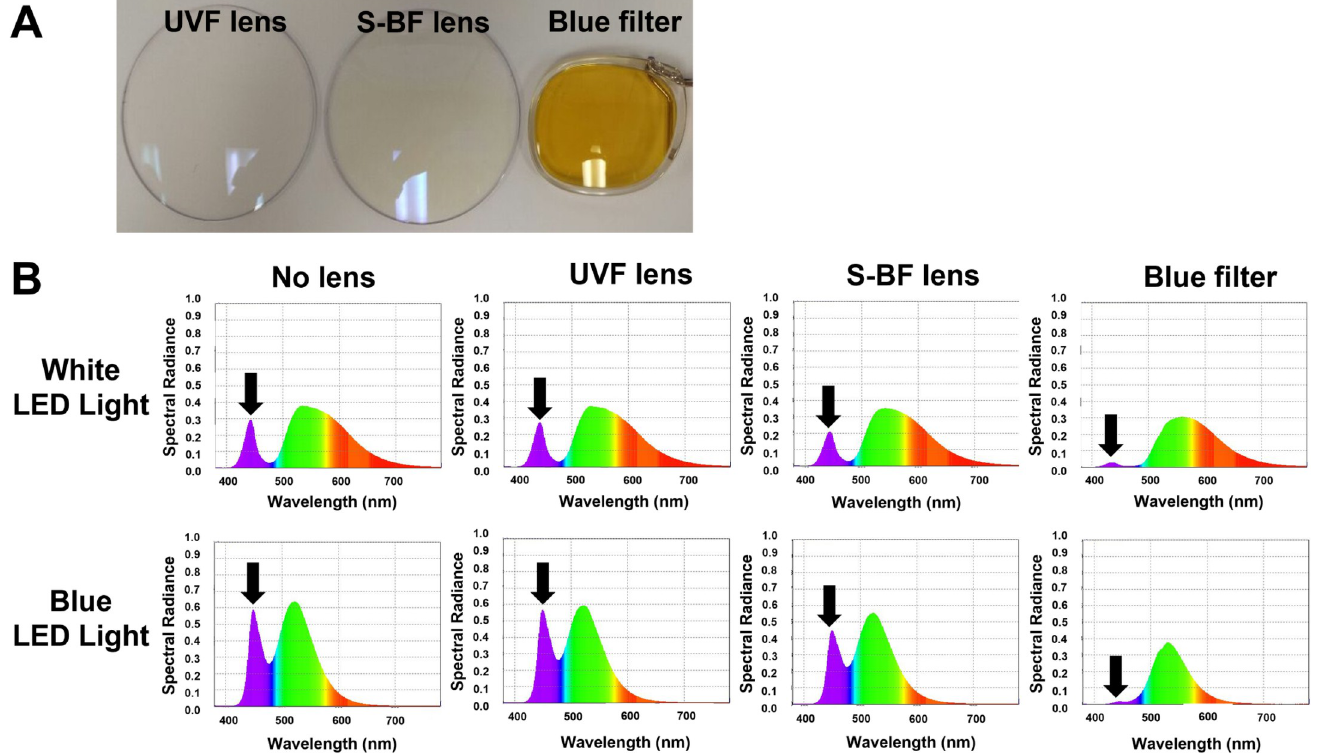
Fig 2. (A) The appearance of different spectacle lenses. Selective blue-filtering (S-BF) lens has a light-yellow tint, while UV-filtering (UVF) lens is transparent, and blue blocking filter lens is deeply yellow-tinted. (B) Spectral radiance of LED lights with and without spectacle lenses. S-BF lens significantly reduced the blue spectrum (black arrows) under both white or blue LED lights when compared to the UVF lens or without lens condition. Blue filter almost completely blocked the blue